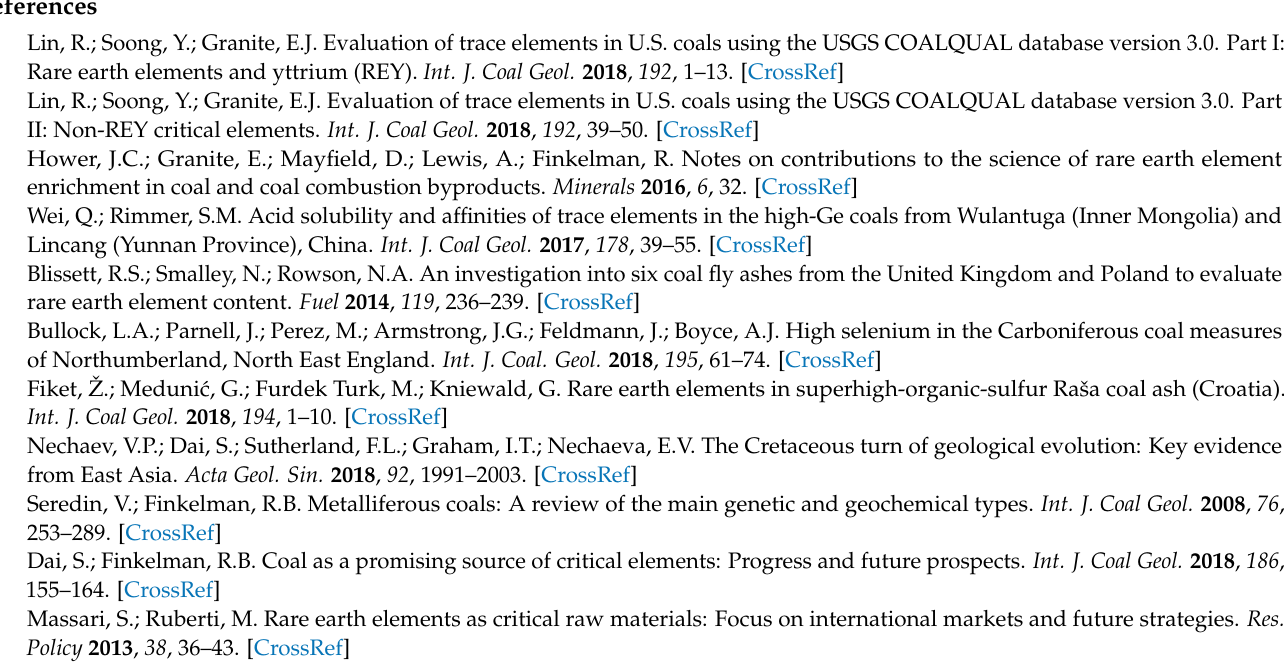
(PSOC) database. Table S5. Data from van der Flier-Keller (1993) [122]. Table S6. Goodarzi et al.’s (2009) Table 6 [117]. Concentrations of elements in coals (mg/kg, coal-base) for the combined geological section of the Elk Valley